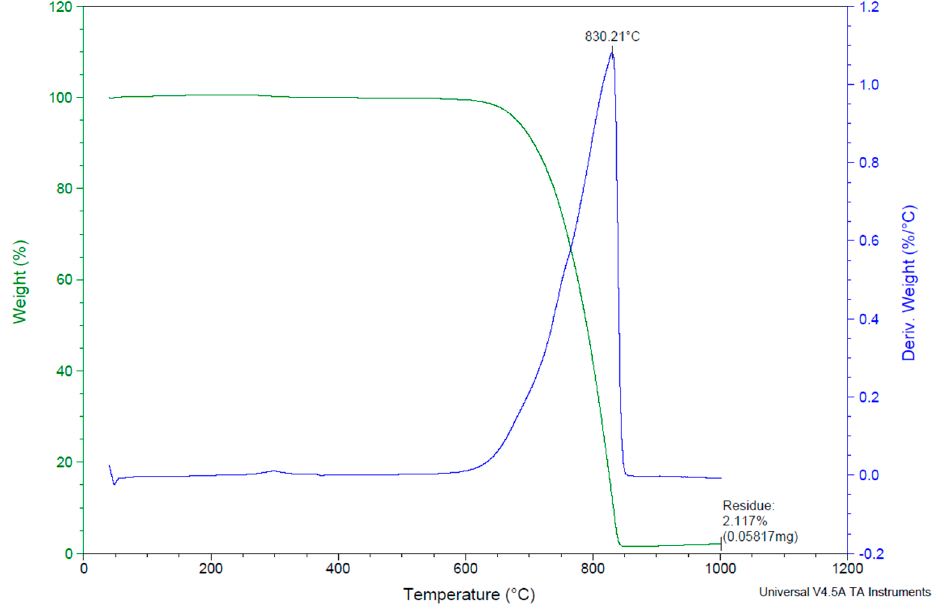
Figure 2. The thermal analysis curve describing the degradation of carbon fibers in the air atmosphere.